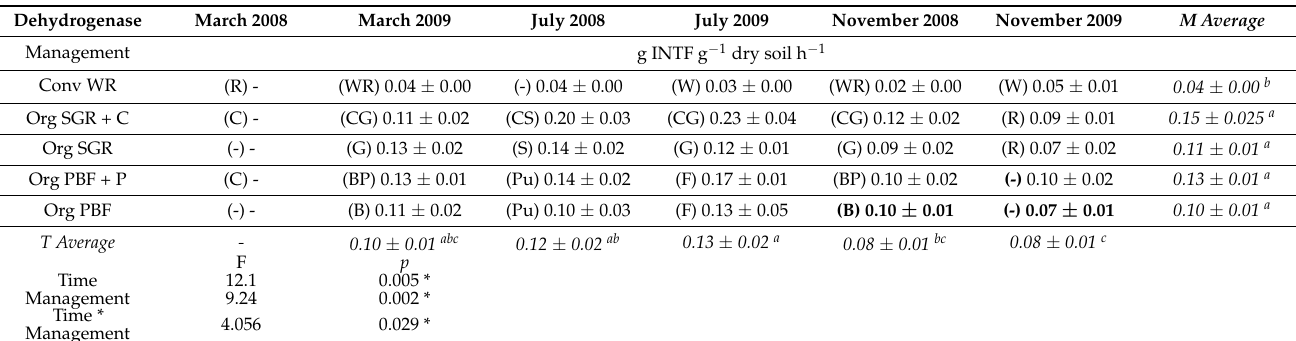
Table 6. Dehydrogenase enzymatic activity in soil.